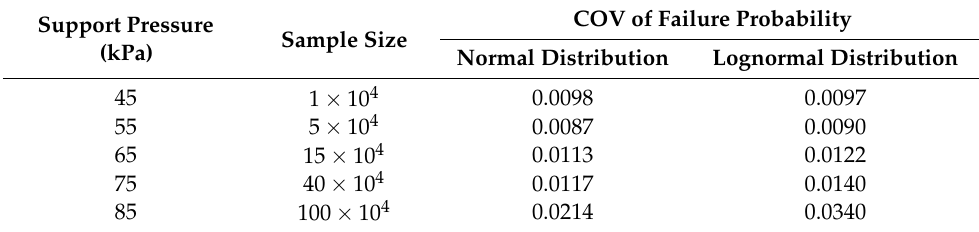
Table 5. The number of trials based on MCS.